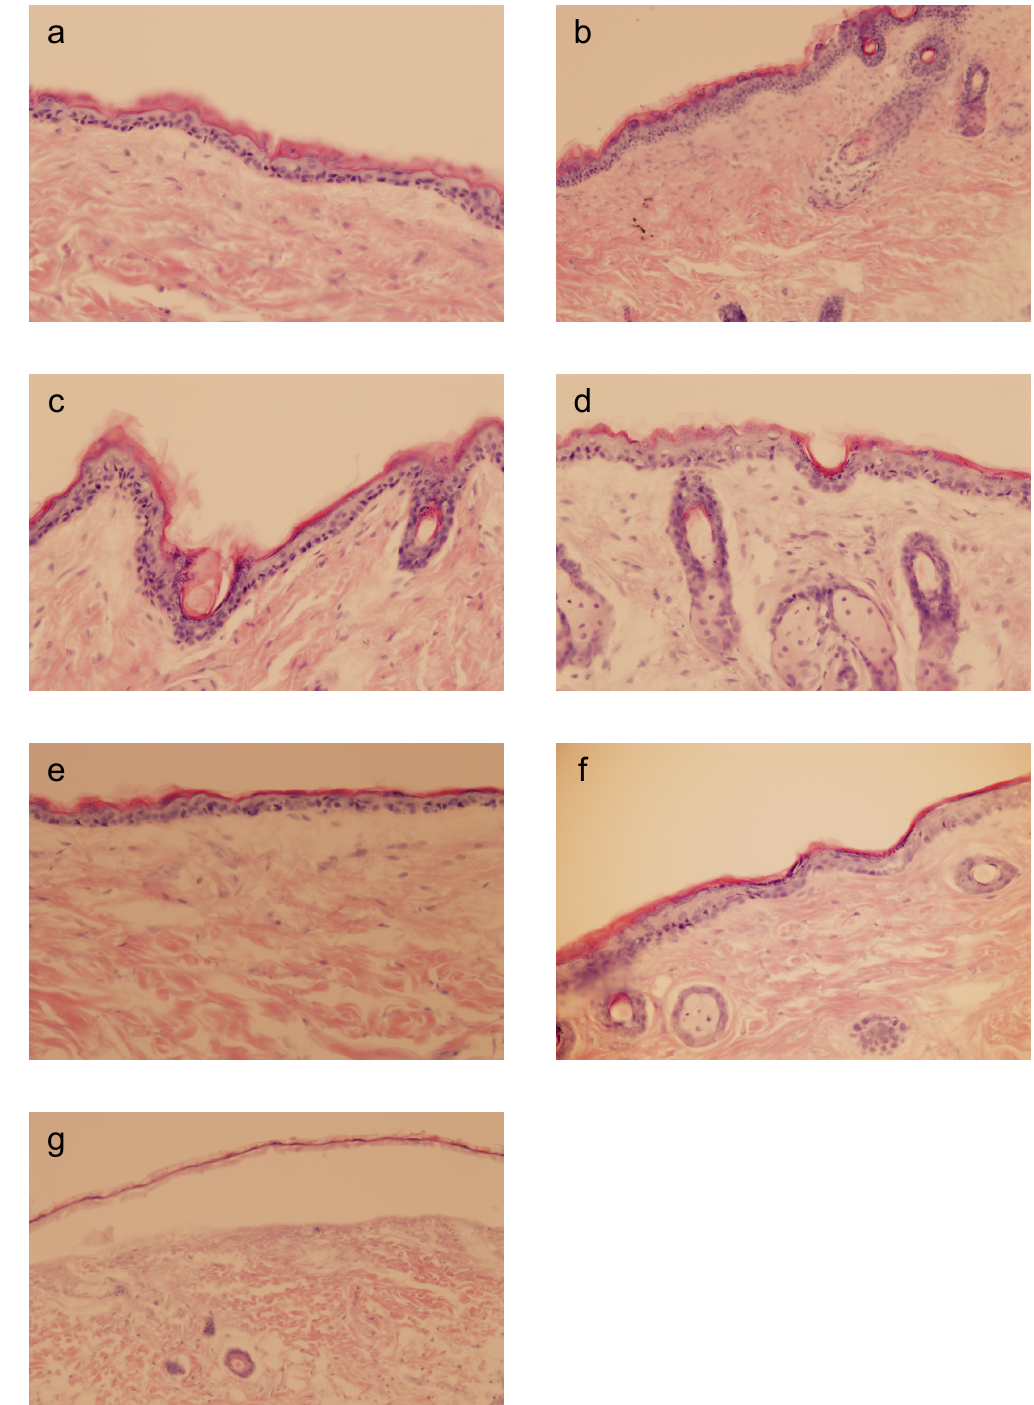
Figure 3. Micrograph of the skin tissues stimulated with 1% fatty acid soap after the hematoxylin–eosin (HE) staining. ( a ) represents the intact skin tissue, magnified with a 20 × objective. Sample treated with water for 1 h is represented in ( b ). The skin tissue samples treated for 1 h with 1% ( c ) sodium stearate, ( d ) sodium isostearate, ( e ) sodium oleate, ( f ) sodium linoleate, and ( g ) sodium laurate. ( b – f ) are magnified with a 20 × objective, and ( g ) with a 10 × objective.